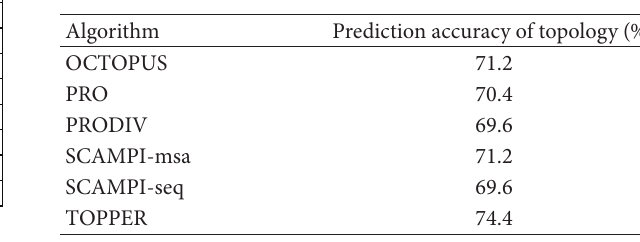
F 6: e comparison of topology’s prediction accuracy between the proposed method and other algorithms. T 4: Prediction performance of various algorithms in topology